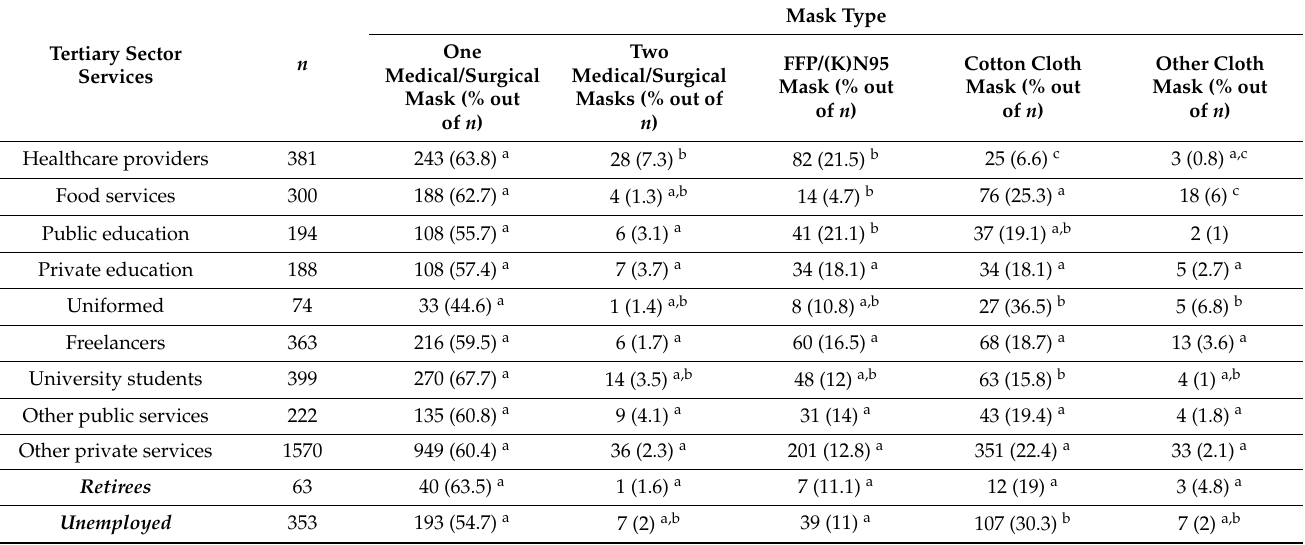
Table 2. Mask type preference/wearing by